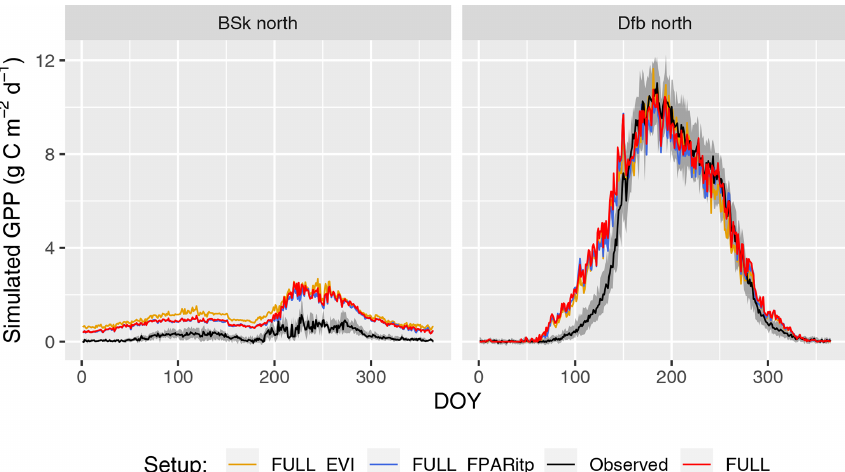
Figure 7. Mean seasonal cycle for model setups with different greenness forcing data for two climate zones (Bsk and Dfb, both in the Northern Hemisphere). Observations are given by the black line and grey band, representing the median and 33%/66% quantiles by day of year (DOY) of all data (multiple sites and years) pooled by climate zone. Coloured lines represent model setups forced with different greenness data. The annotation above each plot specifies the climate zone (see Table 2). Climate zones shown here are illustrative examples.